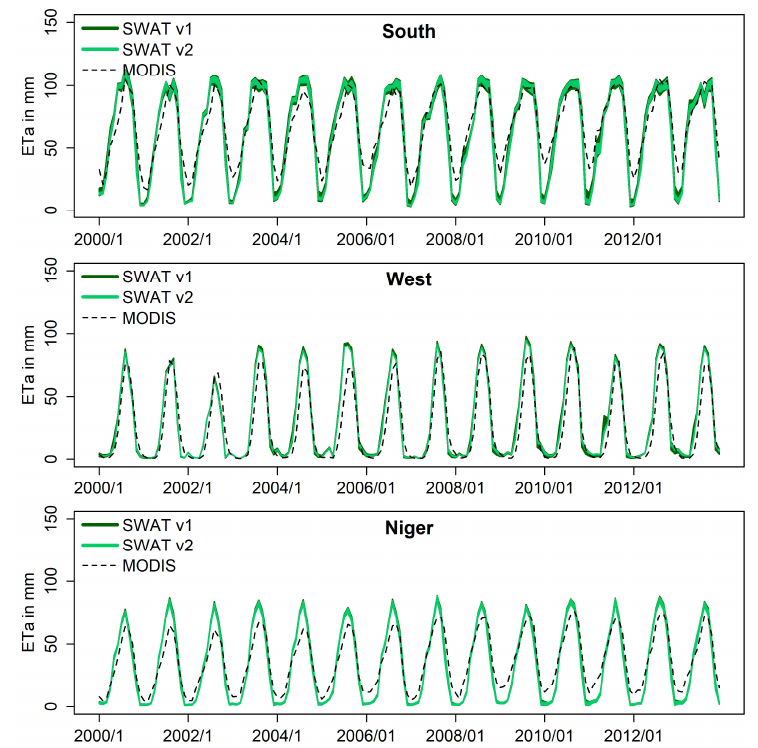
Figure 6. Monthly Simulated Actual Evapotranspiration Validation against MODIS MOD 16 Data, where SWAT v1 is the global and v2 the local calibration.